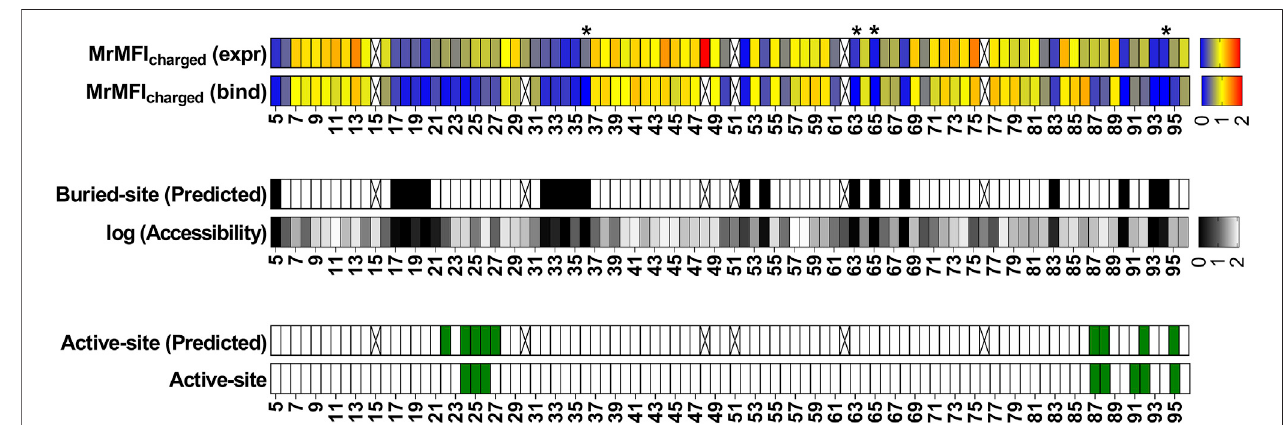
FIGURE 4 | Identi fi cation of buried and active-site residues from MrMFI charged (bind) and MrMFI charged (expr). Side chain accessibilities in dimeric CcdB (PDB: 3VUB), darker to lighter shade indicate increasing accessibility, accessibility is reported as log accessibility. The mutants were clustered into two bins based on the distribution of MrMFI charged and k-means and standard deviations were calculated for both distributions. The distributions were named D1 (higher MrMFI charged ) and D2 (lower MrMFI charged ). Residues which had MrMFI charged (binding) and MrMFI charged (expr) lower than (µ+0.5* σ ) of distribution D2 were characterized as buried. The falsenegativeswereY6,D19,Q21,S22,S70,V75andG77,thepolarsidechainsoftheseresiduesarepointingtowardsthesurface.Active-siteresidueswereidenti fi ed asthose incontactwithGyyrA14 (PDB ID1X75). Residues which had MrMFI charged (binding) less than (µ+ σ )ofD2 distribution and MrMFI charged (expr) higher than (µ-2* σ ) ofdistributionD1werepredictedasactive-site.Weobtainedafewputativefalsepositives.However,theseresiduesarelikelyinvolvedinfunctionalaspectsofactivitythat cannot be inferred from the CcdB:GyrA14 crystal structure. The same residues were seen to be important for CcdB activity in vivo in E. coli (Tripathi et al., 2016). Some positions could not be categorized due to lack of reads, such positions are indicated with an ‘ X ’ . Positions indicated with ‘ * ’ are the ones where MrMFI charged (expr) was observed and the mutants had high read counts but the mutants were absent in MrMFI charged (bind), such positions were assigned MrMFI charged (bind) values similar to other buried positions.